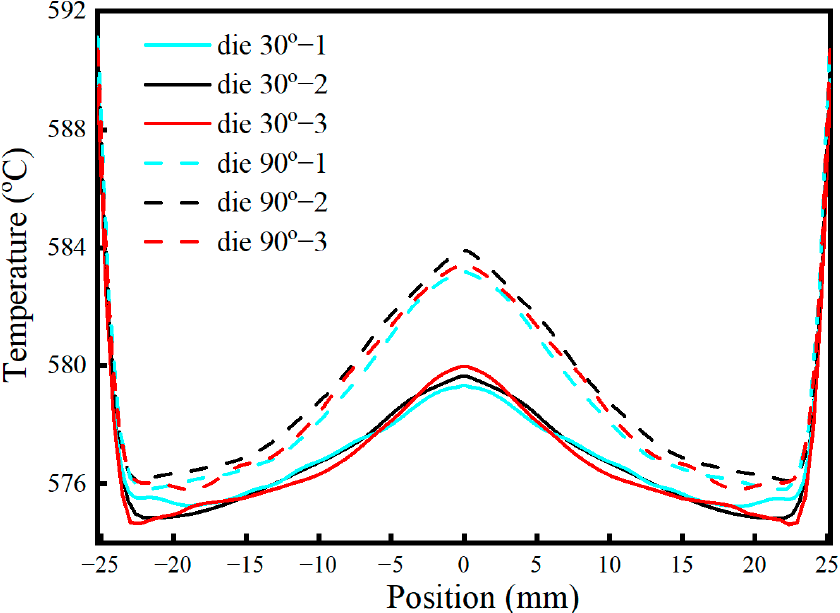
Figure 18. Model predicted exit temperature distribution of the extrudate along the middle thickness (the black line in Figure 17f) and how it is affected by the upper geometry.